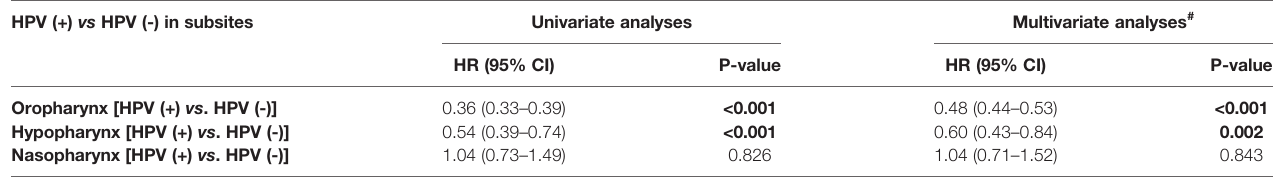
TABLE 2 | Univariate and multivariate analyses of the overall survival in HNSCC arising from the oropharynx, hypopharynx, and nasopharynx. HPV (+) vs HPV (-) in subsites Univariate analyses Multivariate analyses # HR (95% CI) P-value HR (95% CI) P-value Oropharynx [HPV (+) vs . HPV